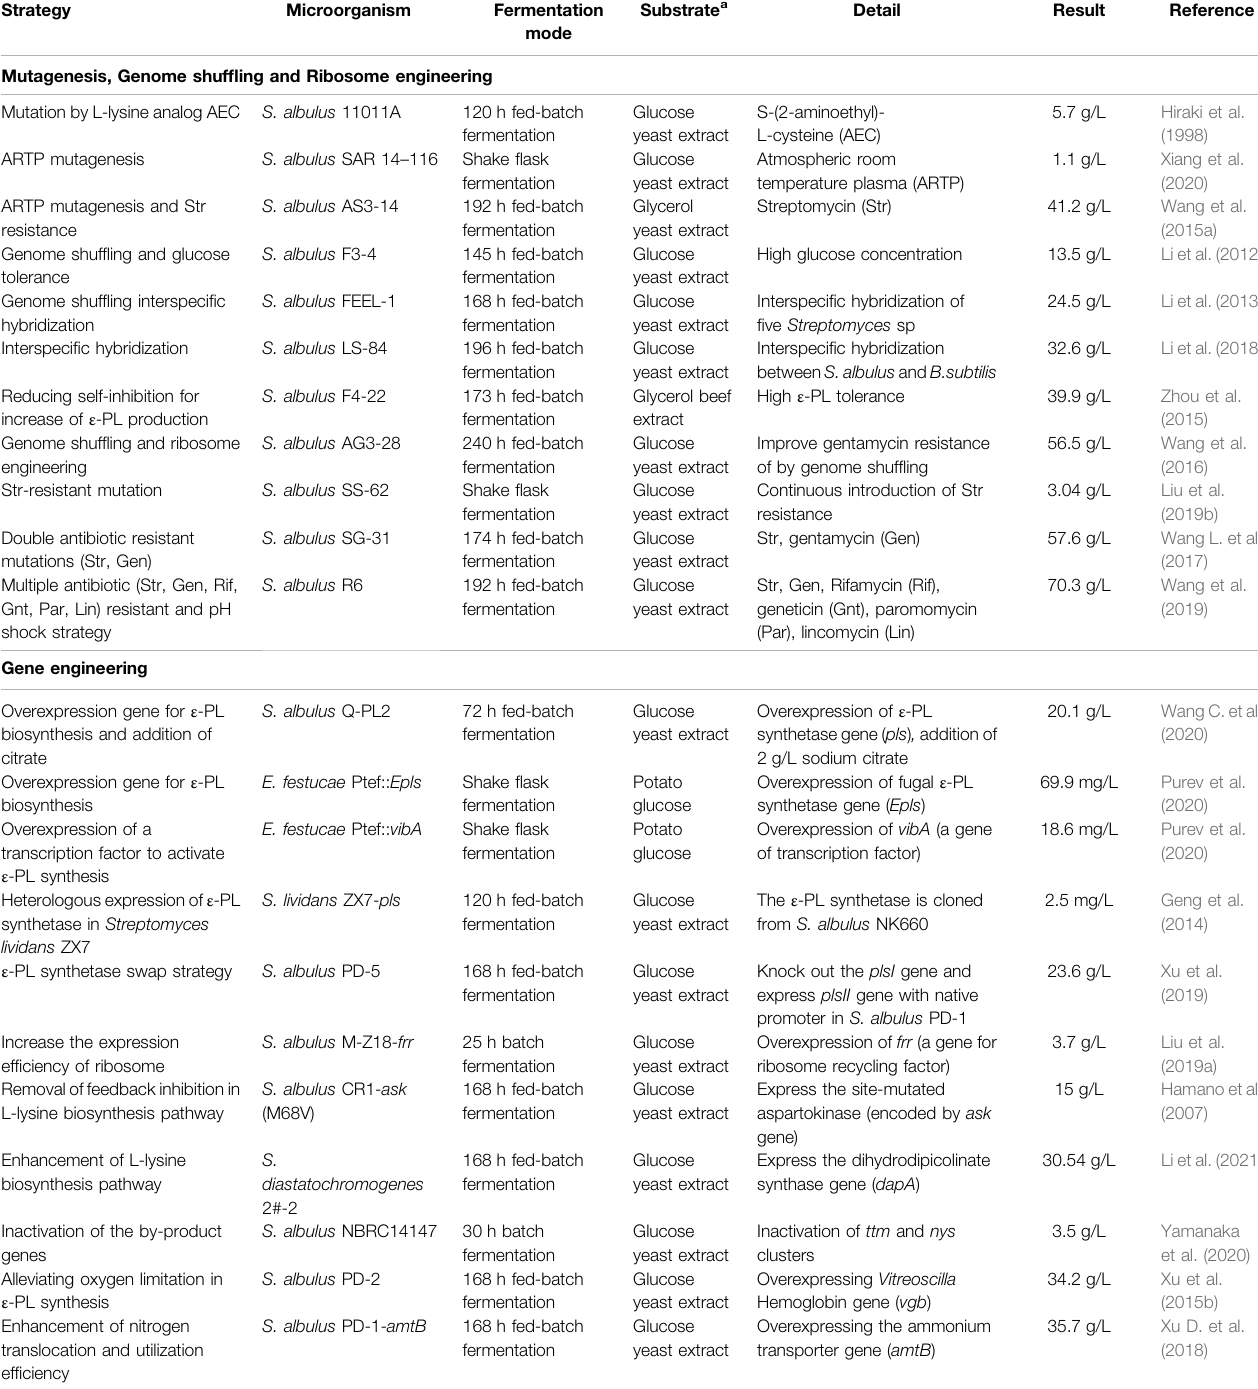
TABLE 1 | Summary of the cell engineering strategies on ε -PL